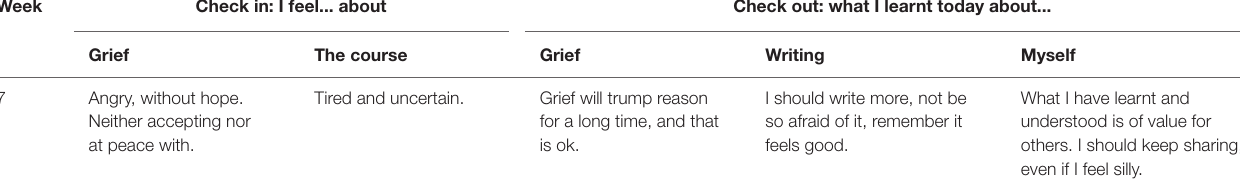
TABLE 4 | Journaling summary from the check-in and check-out prompts. Week Check in: I feel... about Check out: what I learnt today about... Grief The course Grief Writing Myself Angry, without hope. Neither accepting nor